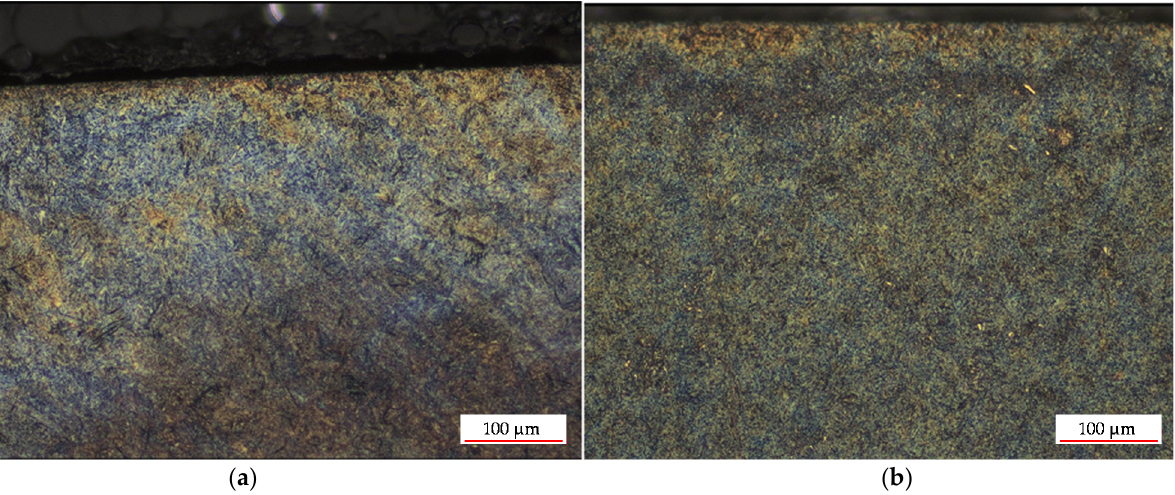
Figure 23. Surface microstructure: ( a ) new cam and ( b ) used exhaust cam 2nd cylinder with the smallest microhardness.